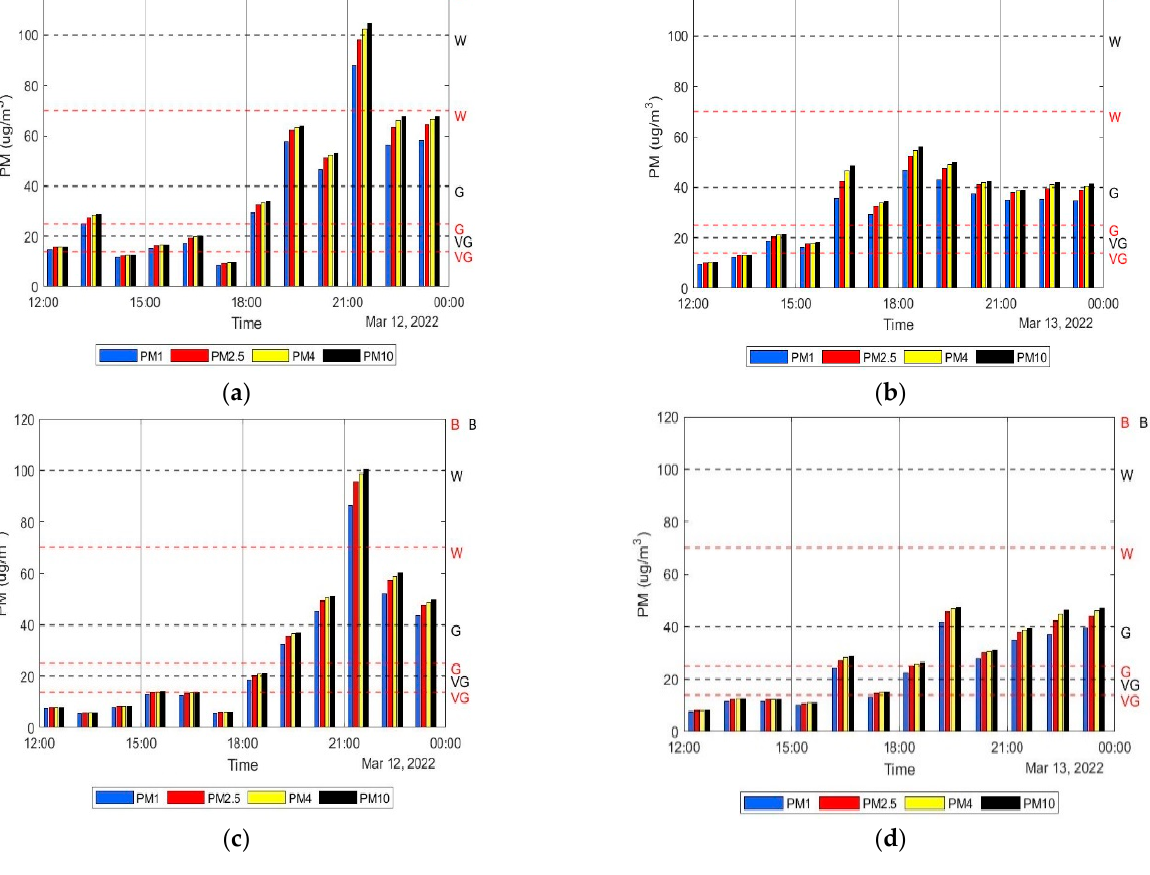
Figure 7. Hourly averages of mass concentration of PM1, PM2.5, PM4, PM10: measured on the balcony in March 2022: ( a ) 12th 12:00–24:00, ( b ) 13th 12:00–24:00; measured in the garden on: ( c ) 12th